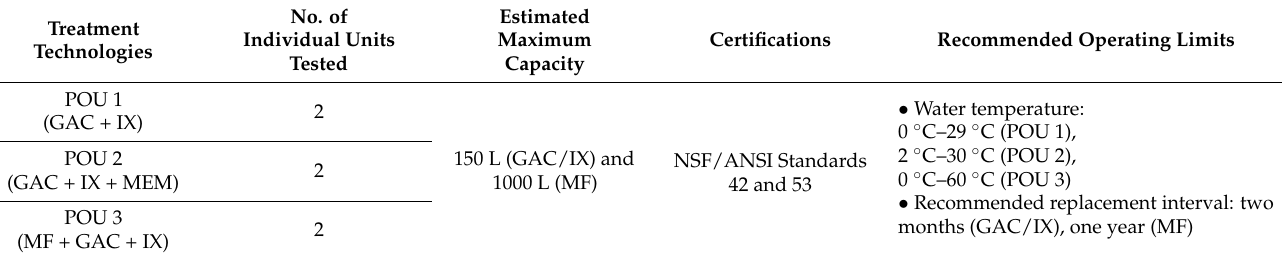
Table 1. Characteristics of selected POU devices.